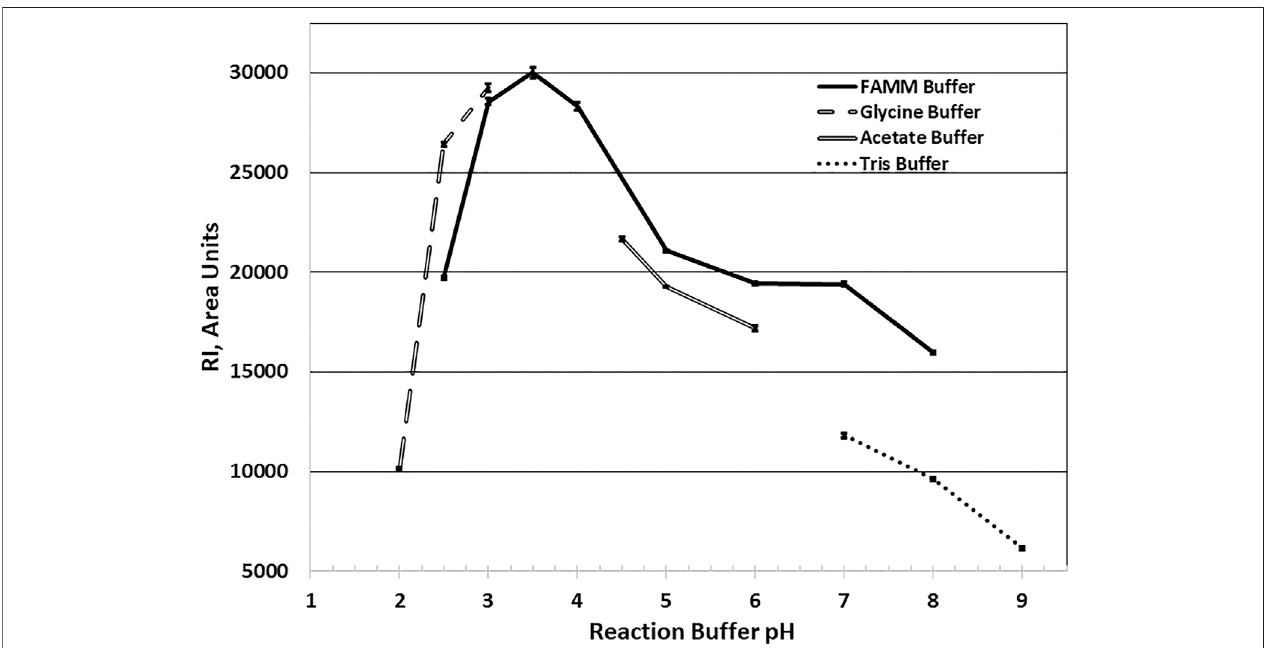
FIGURE 2 | Ac Xbh30A-CD SEP X 4 hydrolysis reaction optimum pH determination. All buffers were used at 30 mM fi nal concentration for each buffer component, and thereactionwasmaintainedat 40Cfor20 minwithBSAincluded at0.02 mg/ml.The fi ndingsshowthat,attheselectedreactiontemperatureof40C,theoptimum reactionpHusingtheFAMMbuffersystemisapproximately3.5.Byextrapolationofthecurve,theoptimalpHismirroredusingthesingle-componentbuffersglycineand acetate. The use of Tris buffer to verify pH activity dependence at the higher pH conditions yielded signi fi cantly lower